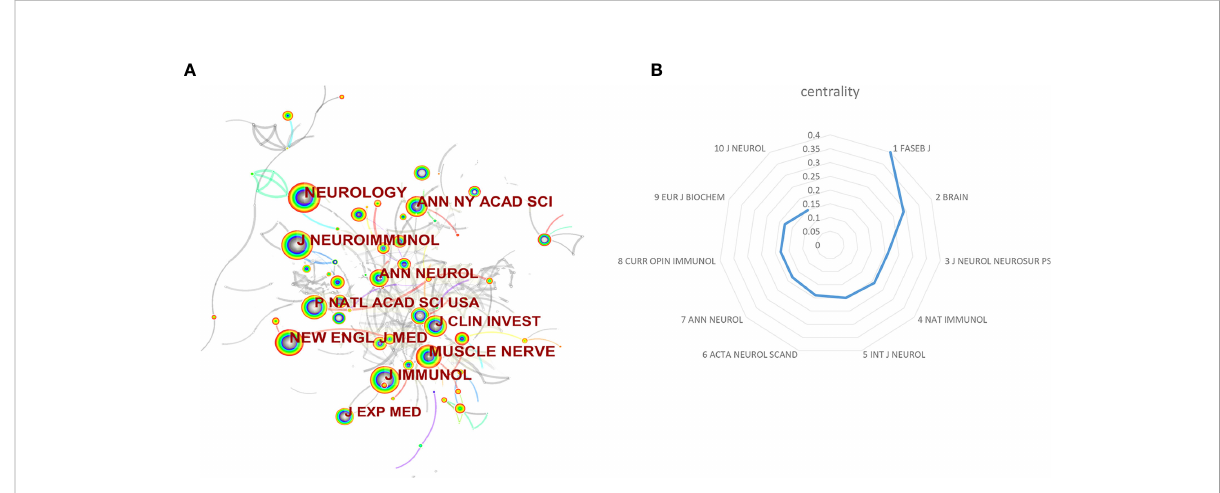
FIGURE 6 (A) Visualization map of journal co-citation analysis by using CiteSpace. (B) The top 10 centrality of journals for the targeted immunotherapy for